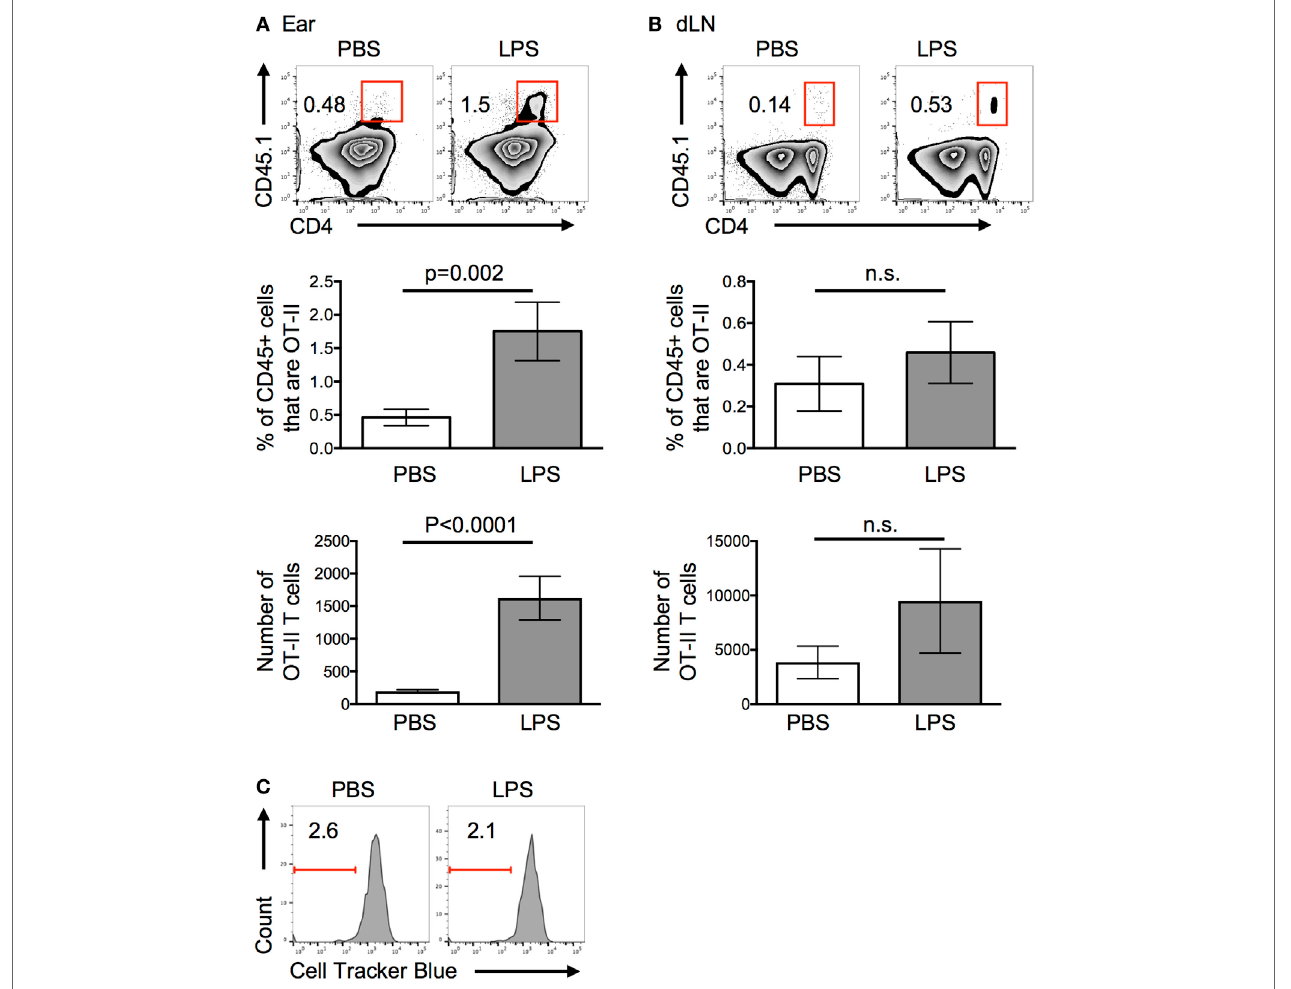
FigUre 2 | Lipopolysaccharide (LPS)-induced inflammation increases the persistence of activated T cells in inflamed sites. Activated OT-II T cells were transferred into the ear pinnae of mice injected with PBS or LPS 24 h previously. After a further 24 h, the percentages and numbers of OT-II T cells in the ears (a) or downstream draining lymph nodes (B) were examined by flow cytometry and their proliferation (c) assessed. In panel (c) , OT-II T cells were labeled with cell tracker blue before transfer. In panels (a,B) , cells are gated on live CD45 + cells and in panel (c) on live CD45 + cells that are CD4 + CD45.1 + (OT-II). Data are representative or combined from three independent experiments with ≥ 3 animals per group. Error bars are